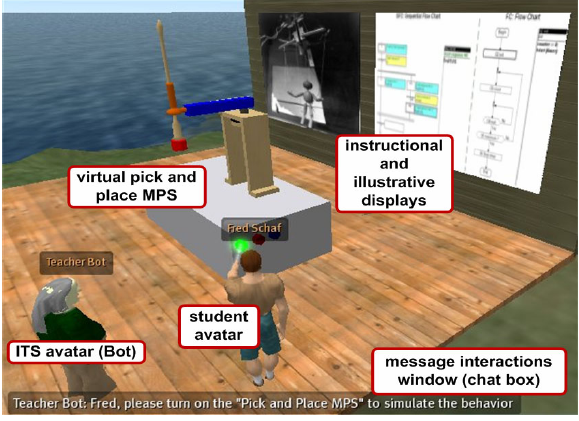
Figure 9. Tutor Bot in the metaverse simple guidance